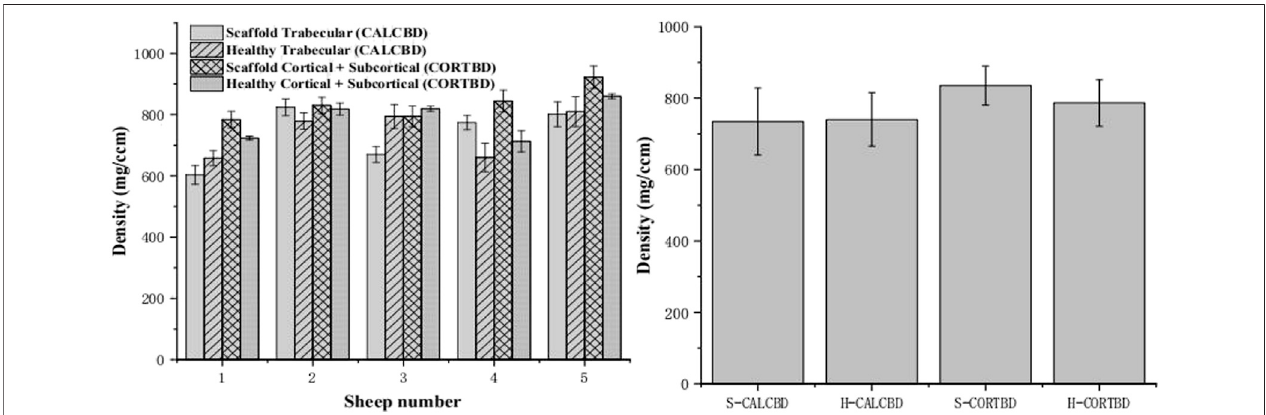
FIGURE 6 | PQCT analysis of the trabecular and cortical BMD of the scaffold and healthy sheep condyle ( left: each sheep; right: in total).